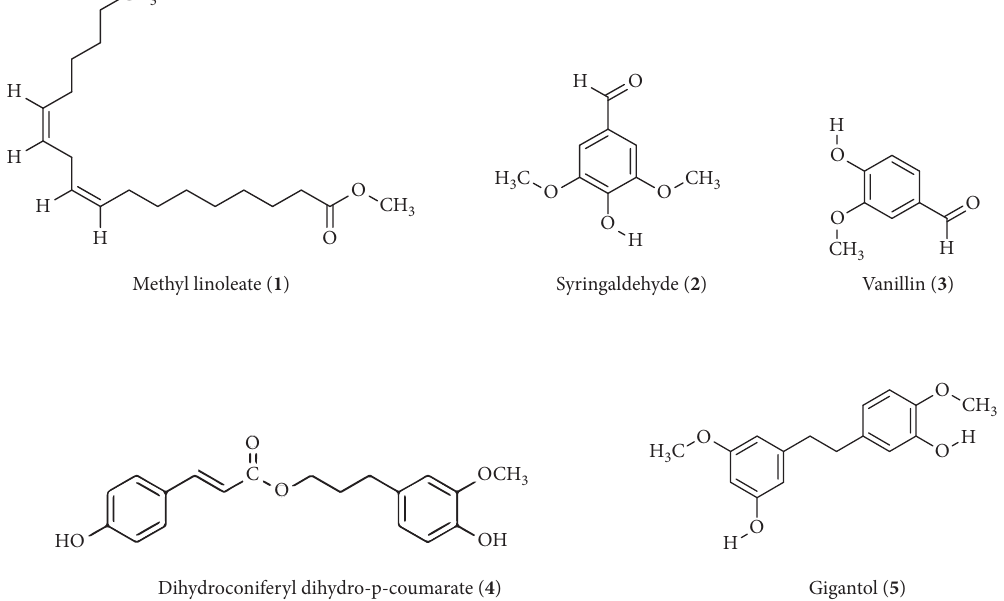
Figure 1: Structures of the isolated compounds 1–5 from the chloroform fraction of Vanda roxburghii